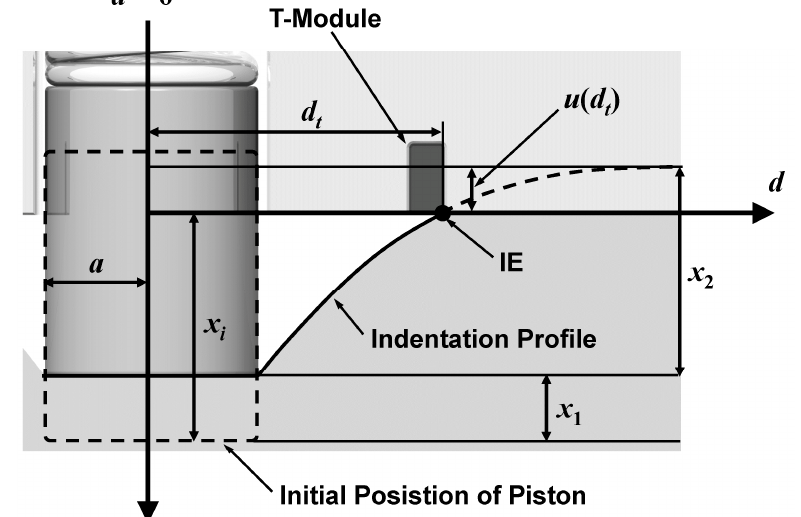
Figure 2. Cross-section diagram of the system during pressurizing stiffness measurement.